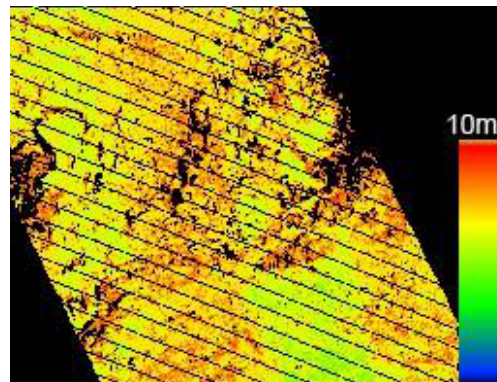
Fig. 6 : Height error map (HEM-file)